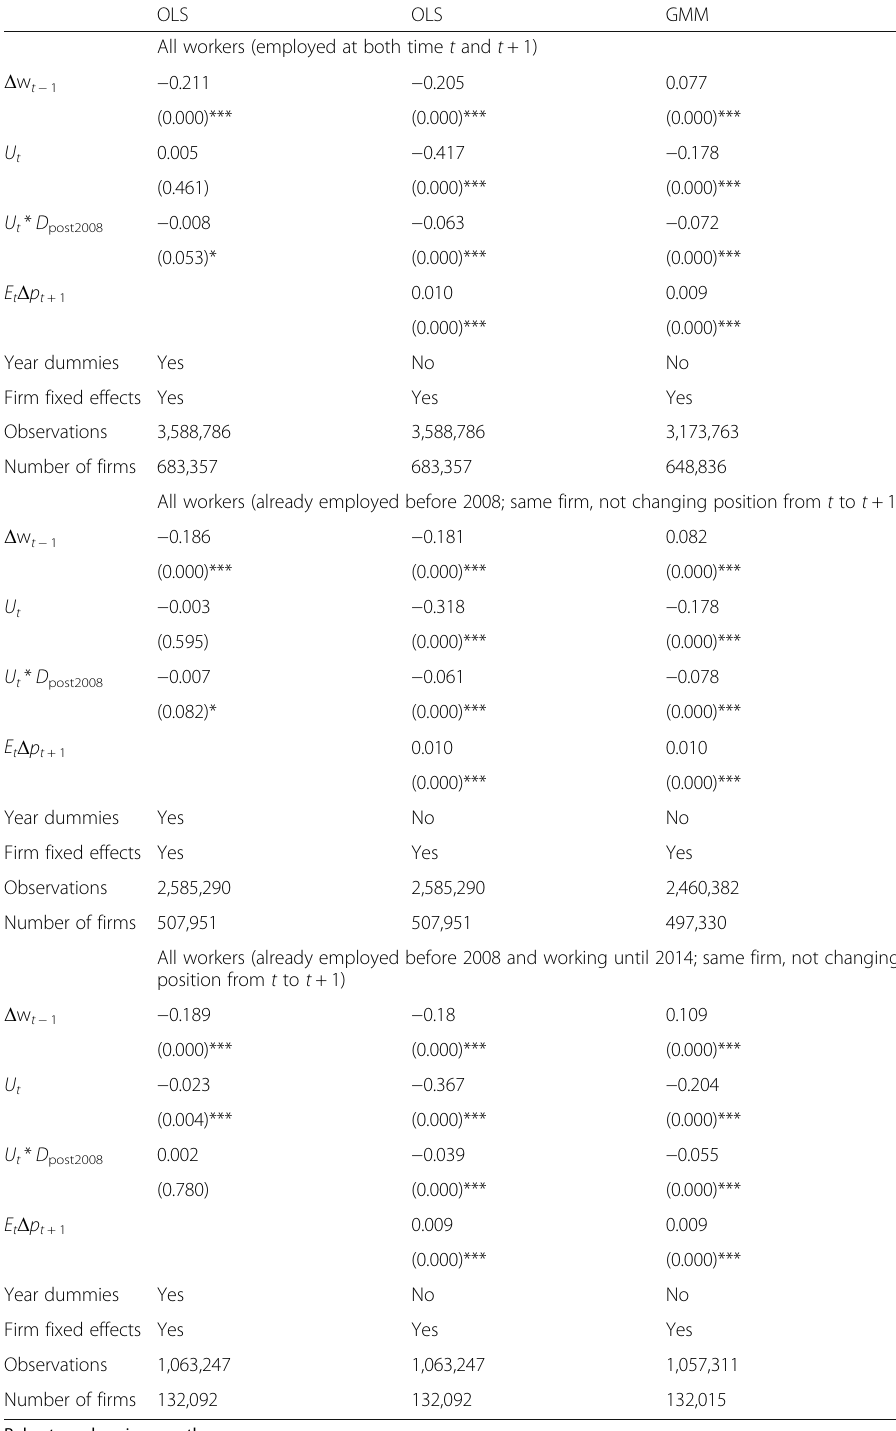
Table 4 Wage Phillips curve in Italy: individual estimates; job stayers ( p values in brackets) OLS OLS GMM All workers (employed at both time t and t + 1) Δ w − 0.211 − 0.205 t − 1